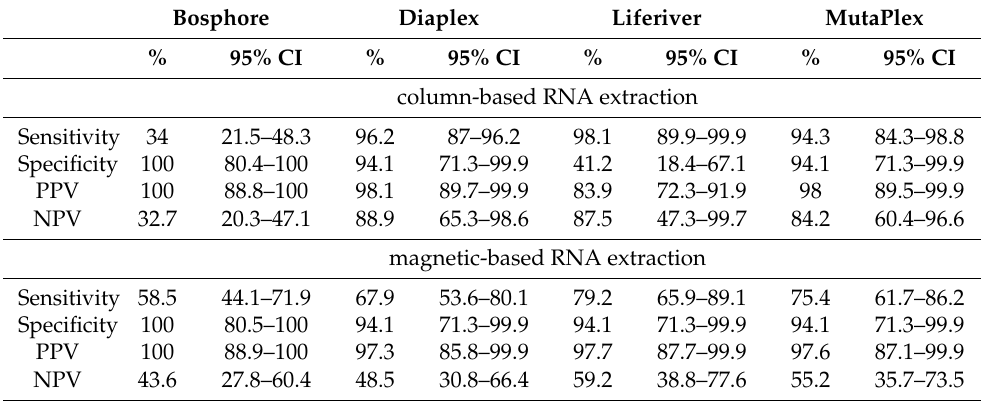
Table 4. Reliability of the studied diagnostic tests. CI: confidence interval, PPV: positive predictive value, NPV: negative predictive value.